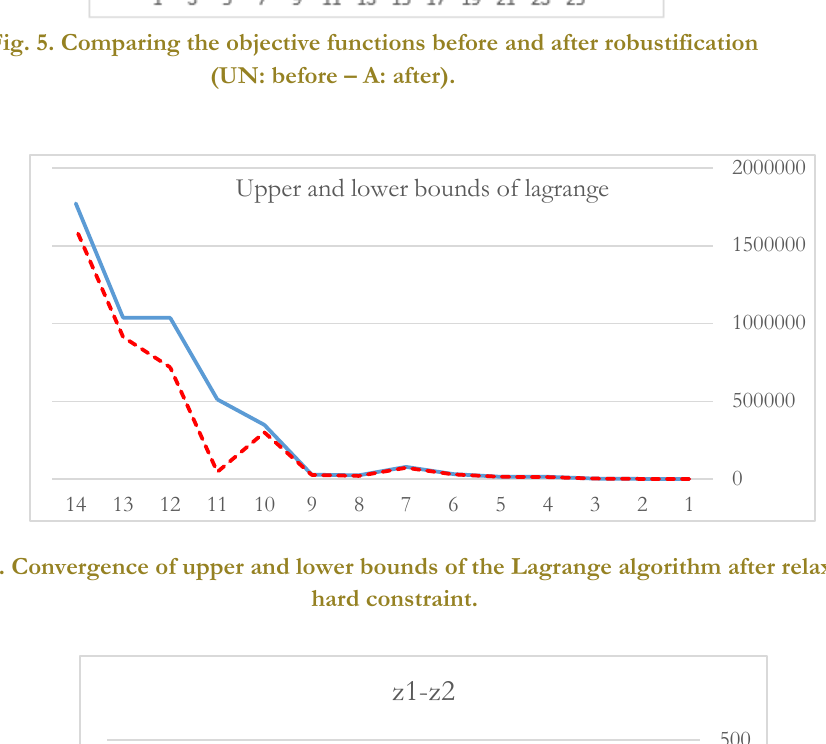
(lagrangian relaxation).